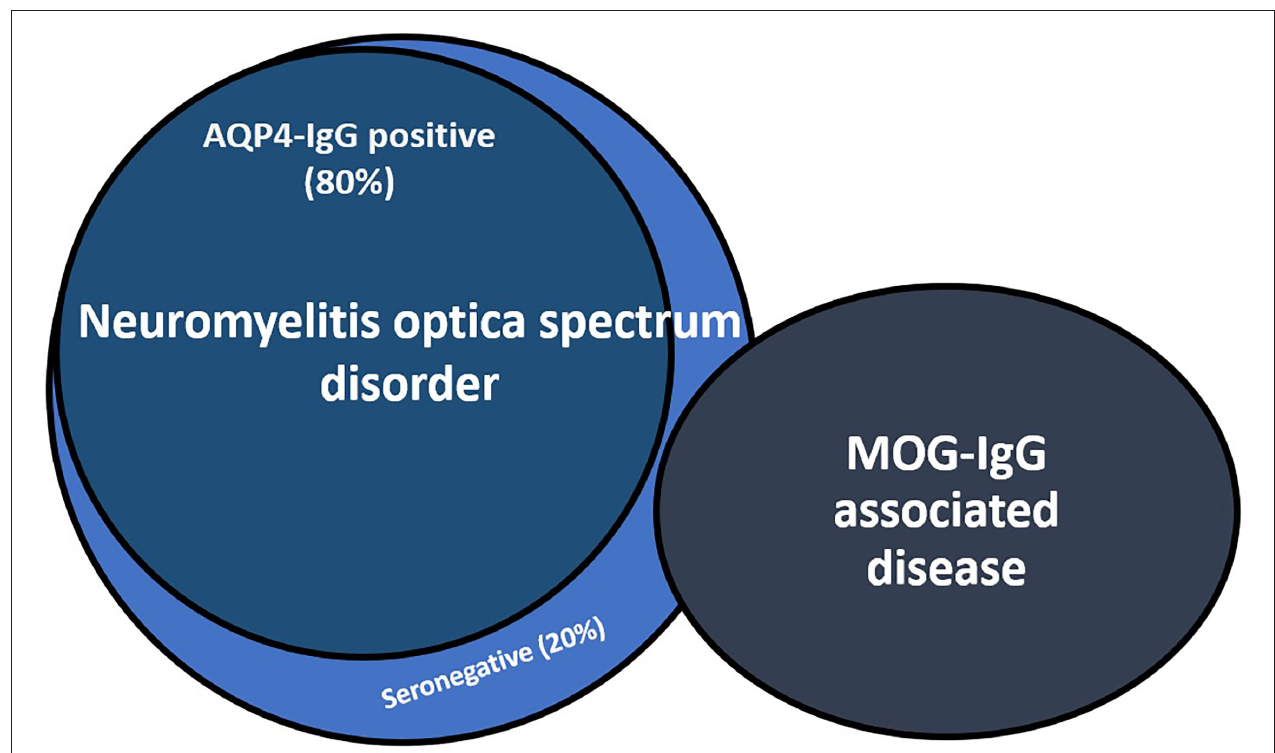
FIGURE 1 | Relationship between aquaporin-4-IgG seropositive and seronegative neuromyelitis optica spectrum disorder (NMOSD) and myelin oligodendrocyte glycoprotein antibody-associated disease (MOGAD). About 30% of NMOSD seronegative patients results positive for MOG-IgG. AQP4-IgG, aquaporin-4 antibodies; MOG-IgG, myelin oligodendrocyte glycoprotein